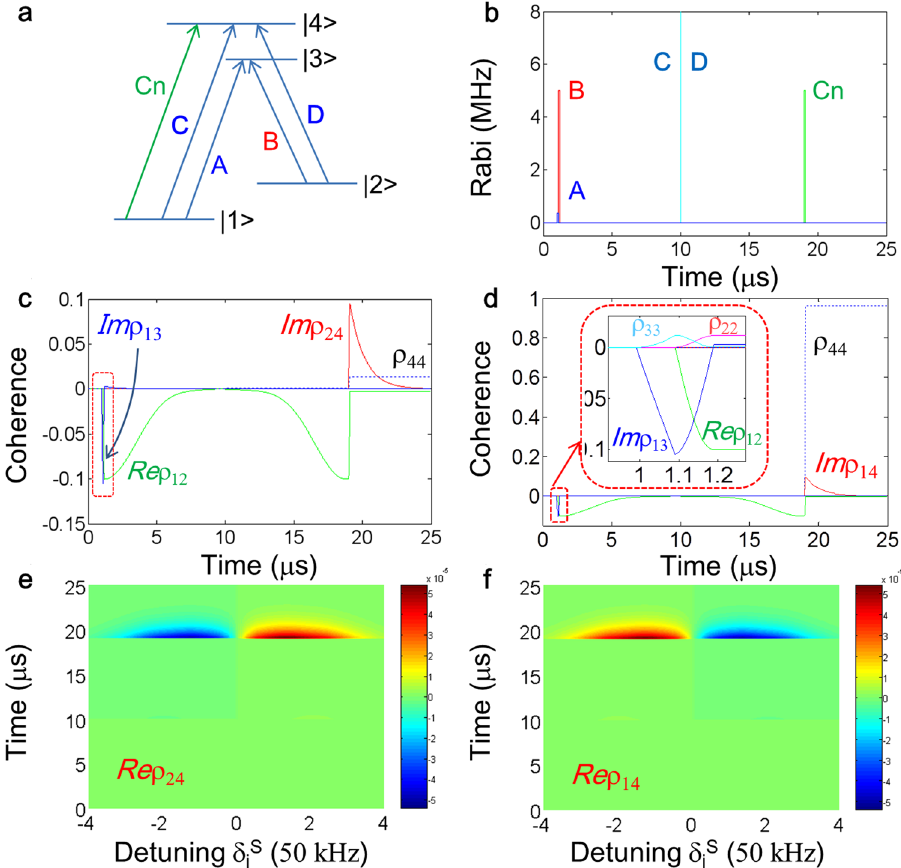
Figure 3. A wavelength-convertible controlled echo. ( a ) and ( b ) Energy level diagram and pulse sequence. The optical pulses C and D are for resonant Raman rephasing whose pulse area is 2 π , and each Rabi frequency is Ω = . ( c – f ) Numerical calculations, Ω = Ω = 100/ 2 MHz . The control Rabi frequency Cn is 5 MHz C D Cn where Cn is for the transition − 1 4 in ( c ) and ( e ), and − 2 4 in ( d ) and ( f ). The dotted box in ( c ) is the same as the inset in ( d ). All decay rates are zero except for the optical homogeneous decay rates of 150 kHz. All other parameters are the same as in Fig.